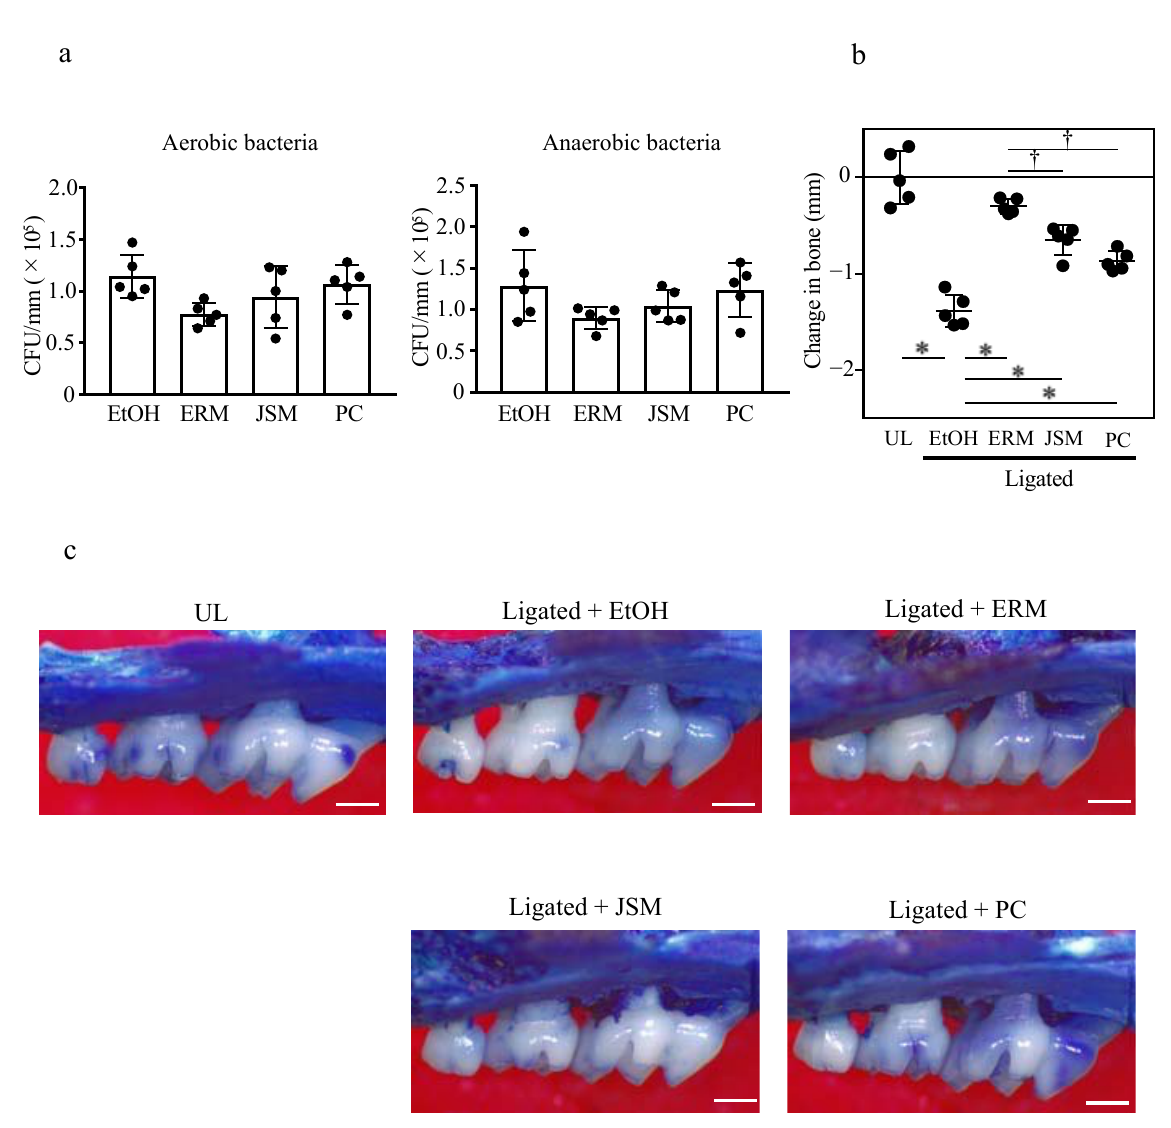
Figure 1. Peritoneal injection of antibiotics inhibits bone resorption in ligature-induced periodontitis. Periodontal bone loss was induced by ligating the maxillary second molar. The unligated (UL) group was set as the baseline control. Groups of mice were administered intraperitoneally with 20% ethanol (EtOH; control), penicillin (PC), josamycin (JSM), or erythromycin (ERM). ( a ) Number of aerobic and anaerobic bacteria attached to the silk ligature. ( b ) The distance from the cement-enamel junction to the pinnacle of the alveolar bone was measured. Negative values (in mm) indicate bone loss relative to the UL control. ( c ) Representative images of mouse maxillary bones from the indicated groups (scale bars, 0.5 mm). * p < 0.05, compared to the EtOH group; † p < 0.05, compared to the ERM group, means ± SD ( n = 5 per group).